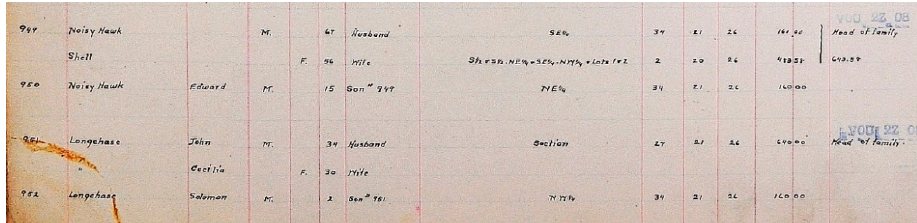
Figure 11. Sample image from the allotment ledger books, available from the National Archives. Note the variety of land descriptions in the middle column: one full section, one half-section, three quarter-sections, two quarter-quarter-sections, and two